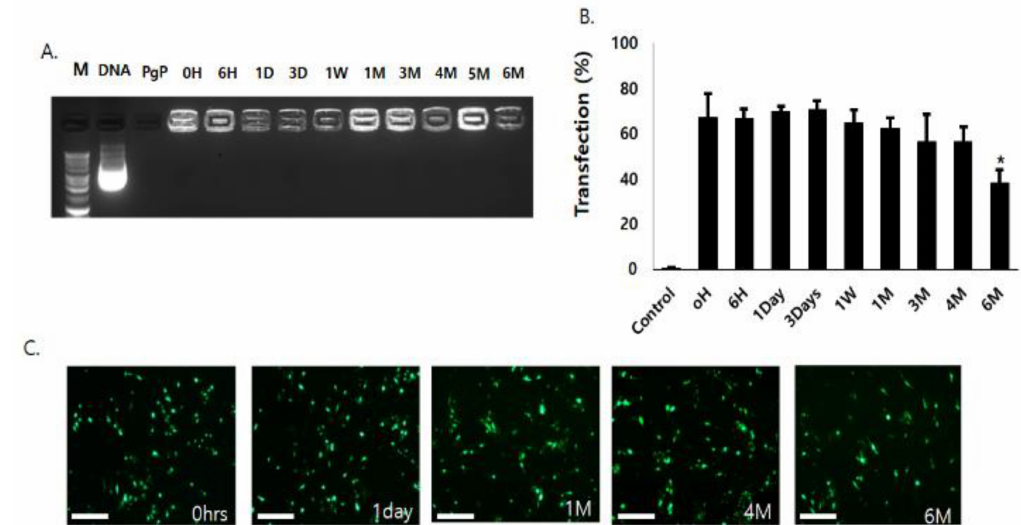
Figure 3. Long-term stability of PgP / pGFP polyplexes (2 µ g pGFP, N / P ratio 60 / 1) at 4 ◦ C. ( A ) Gel retardation assay by 1% agarose gel electrophoresis of PgP / pGFP polyplexes. M: Molecular weight marker (lane1), DNA: naked pDNA (lane 2), PgP only (lane 3), lanes 4–13: Polyplexes at pre-determined timepoints(0, 6h, 1, 3, 7days, 1, 3, 4, 5and6months, respectively)duringstorageat4 ◦ C.( B )Transfection e ffi cacy of polyplexes stored at 4 ◦ C in C6 cells in media containing 10% serum at pre-determined time points. Data represent the mean ± SD. * p < 0.05 compared with freshly prepared polyplexes. ( C ) Representative images of GFP-positive cells at 2 days post-transfection with PgP / pGFP polyplexes stored 4 ◦ C. Scale bars indicate 100 µ